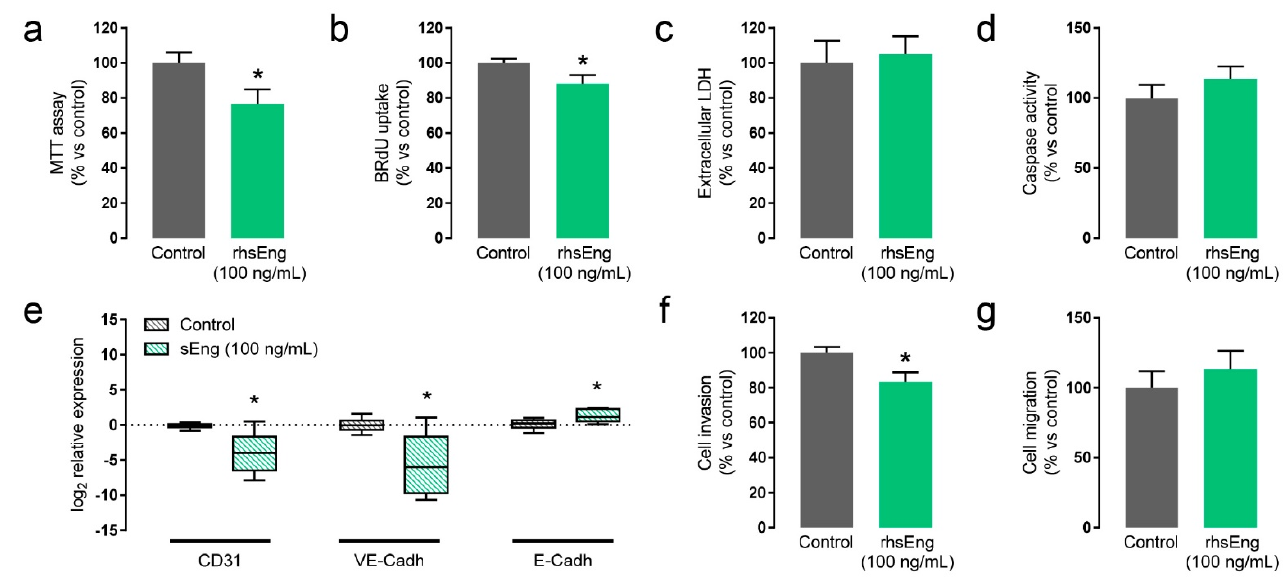
Figure 5. Soluble endoglin modifies cytotrophoblast cell biology. ( a , b ) Effect of rhsEng on JAr cell proliferation measured by MTT assay after 5 days in culture ( n = 5) ( a ) or BrdU incorporation during 2.5 h ( b ) ( n = 5); ( c ) Effect of rhsEng on trophoblast cell necrosis evaluated measuring extracellular levels of lactate dehydrogenase (LDH) of JAr cells treated or not with rhsEng ( n = 4); ( d ) Caspase activity in cell lysates of JAr cells treated or not with rhsEng ( n = 7); ( e ) qRT-PCR analysis of PECAM1, VE-cadherin, and E-cadherin expression in human placental extracts treated or not with rhsEng ( n = 6); ( f ) Quantification of JAr invasiveness through the Matrigel ® -coated transwell in fetal bovine serum (FBS) gradient, with or without rhsEng treatment ( n = 6); ( g ) Quantification of JAr migration through the uncoated transwell in FBS gradient, with or without rhsEng treatment ( n = 5). Mean ± SEM are displayed. * p < 0.05 of 100 ng/mL of rhsEng vs.